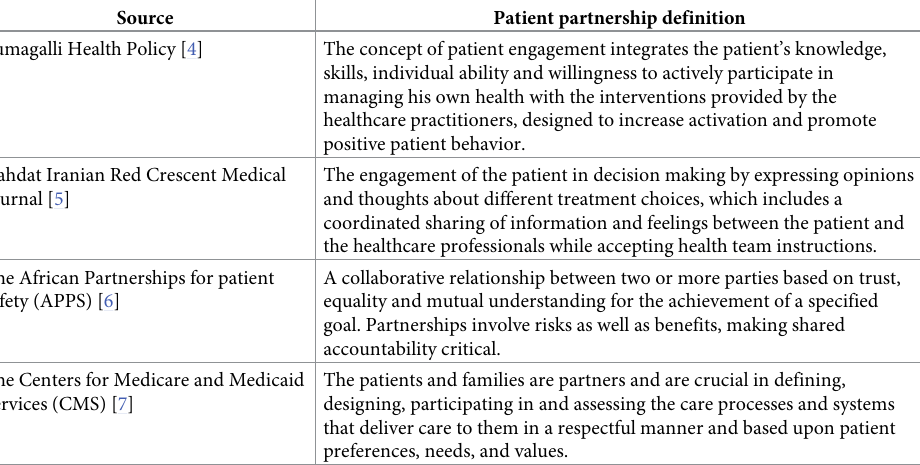
Table 1. The different patient partnership definitions from